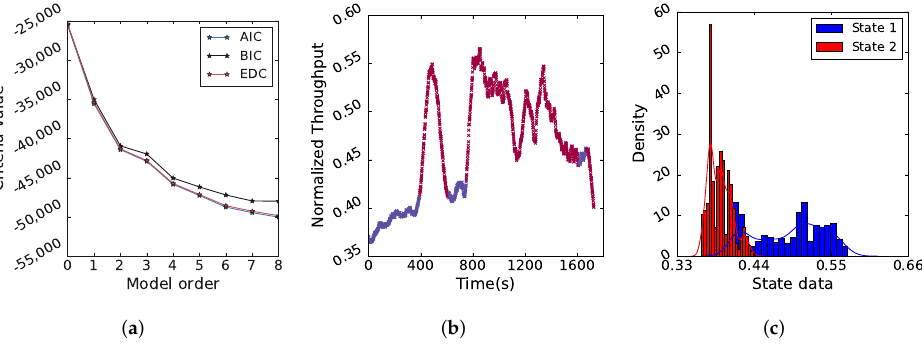
Figure 4. The criterion values, y-axis, suggest a second order HMM for the dataset consisting of 5 work-cycles ( a ); the identified states by the second-order model are color-coded in ( b ); ( c ) shows distribution of the data in each